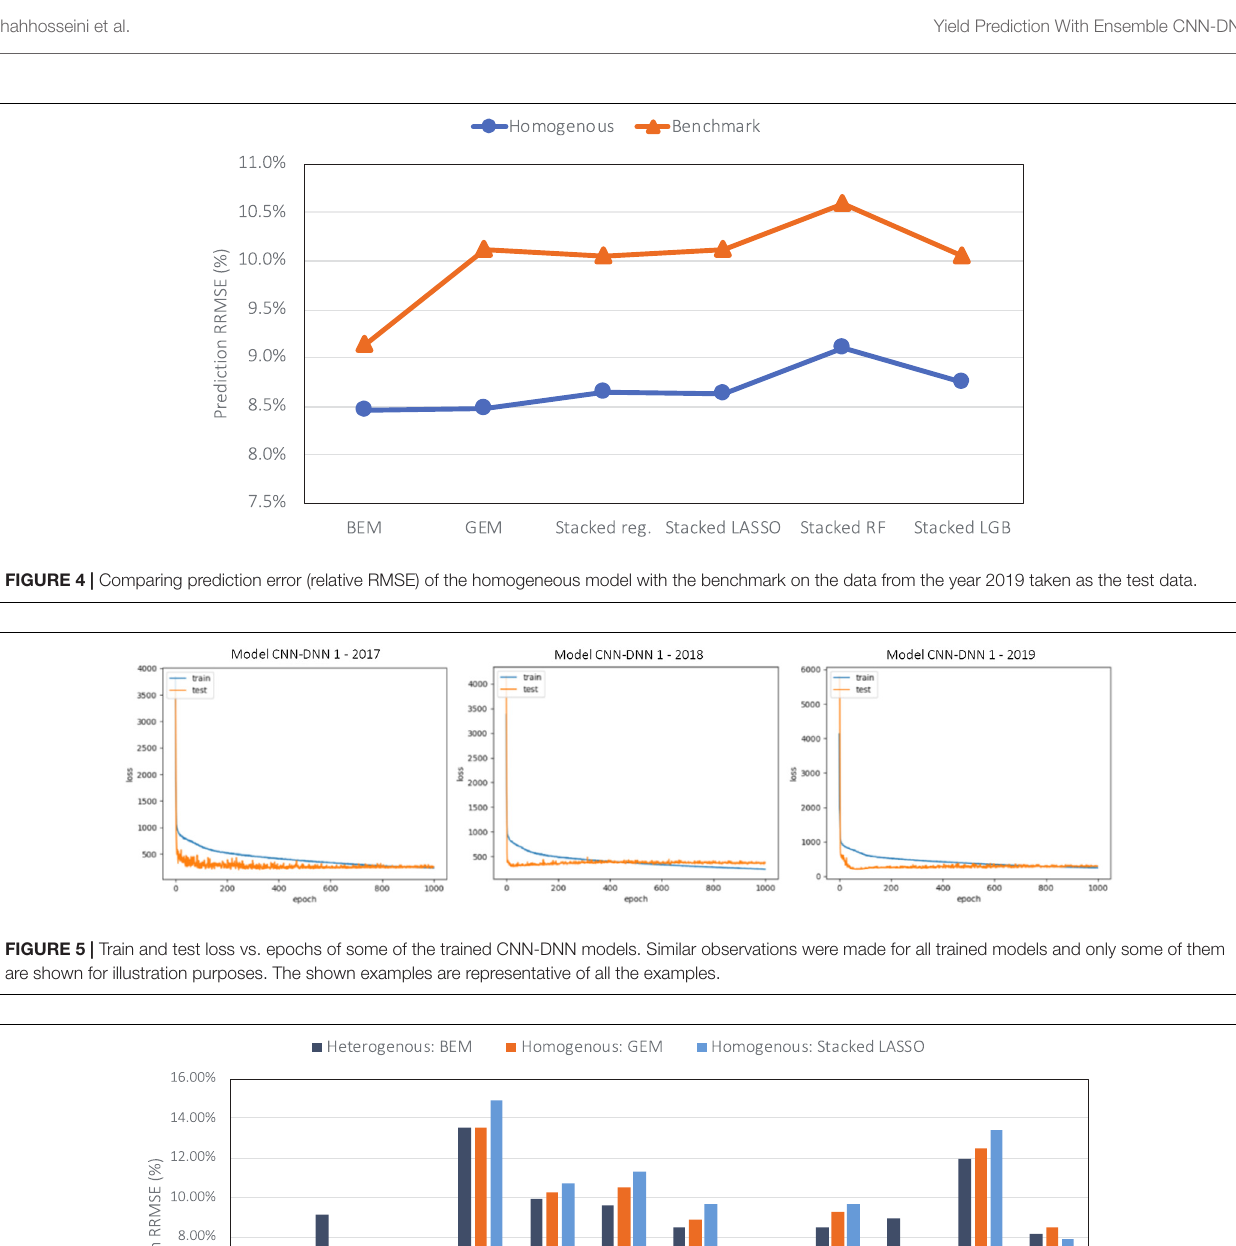
Table 1 . We have resampled the training data 10 times (with replacement) and trained the same CNN-DNN model on each of the 10 newly created training data. The OOB predictions are the predictions made by each of the 10 mentioned models on the validation